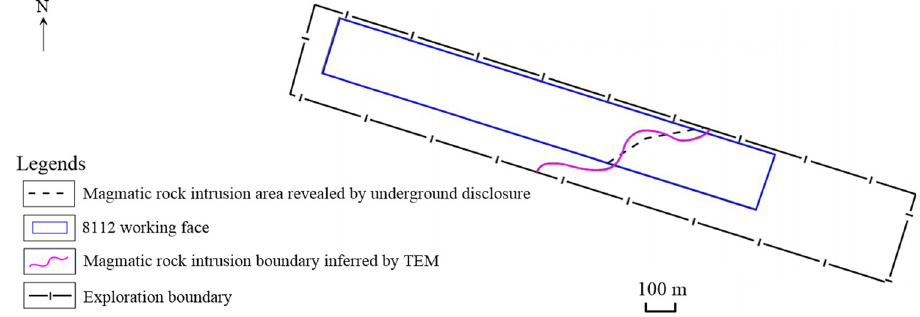
Fig 9. Comparison of magmatic rock intrusion revealed by underground survey with TEM